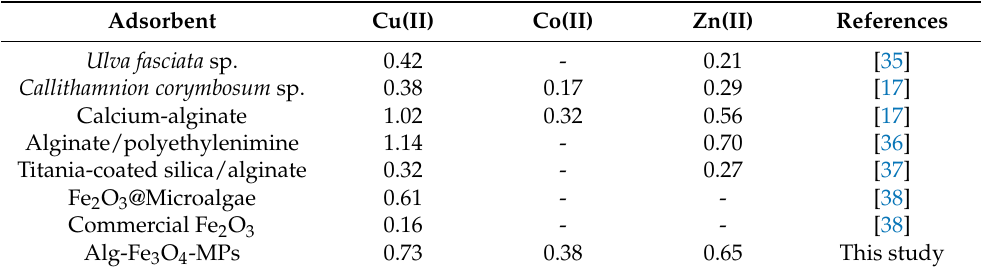
Table 2. Comparison of the maximum biosorption capacity (q max , mmol/g) of Alg-Fe 3 O 4 -MPs for Cu(II), Co(II) and Zn(II) ions with similar algae-based materials.